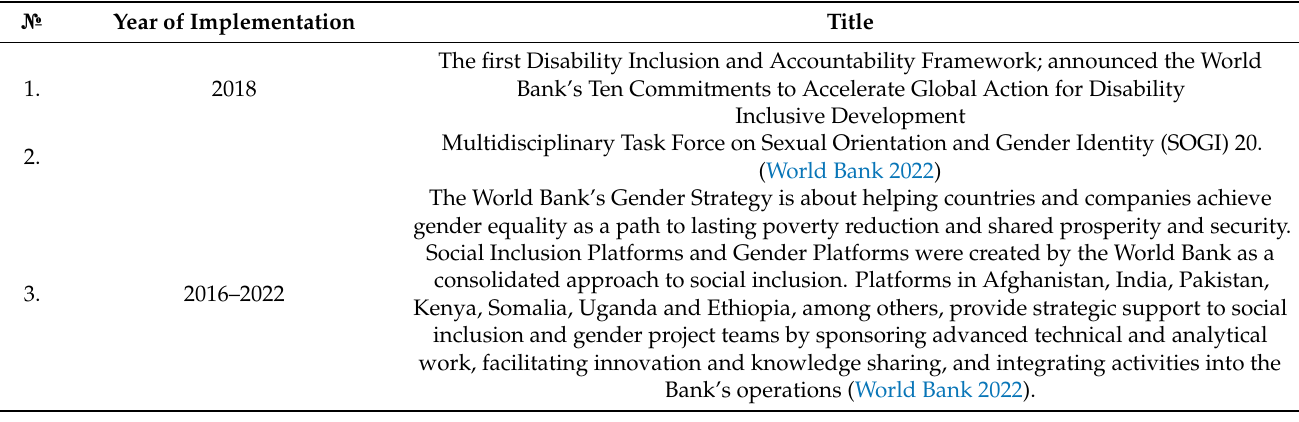
Figure 2. Visualized results of regression analysis of the social component. Table 4. Activities of the World Bank towards Social Inclusion and